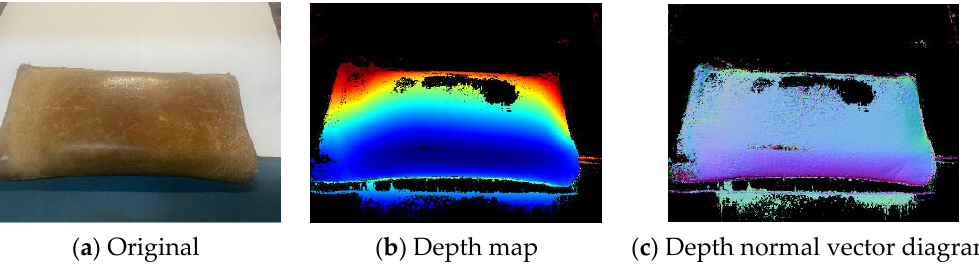
Figure 13. ( a – c ) are the original image, depth map and depth normal vector map corresponding to the original map.